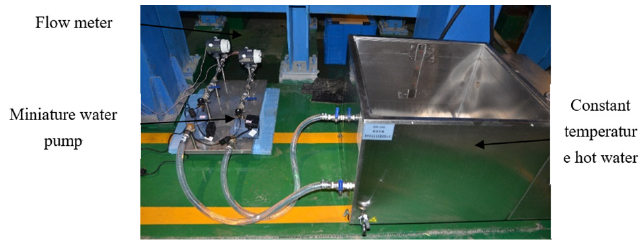
Figure 7. Cooling water discharge device.